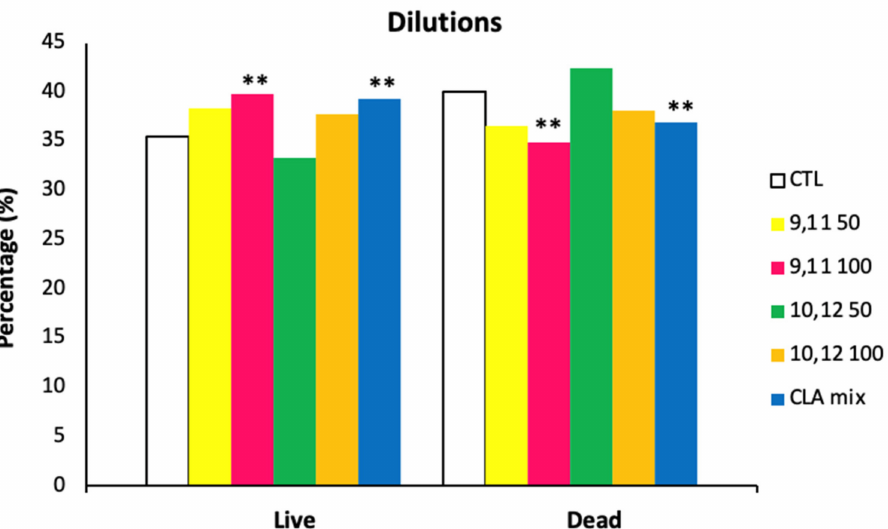
Figure 7. Influence of CLA supplementation and addition at different concentrations to Triladyl ® on post-thawed dairy bull semen for flow cytometer analysis of the percentage of live and dead sperm (LSM ± SE) for Control (CTL), CLA group. ** significant at 100 µ M CLA c 9, t 11 and CLA Mix as p ≤